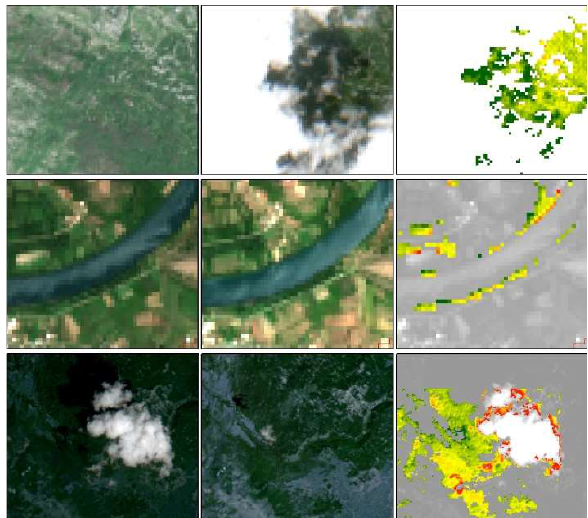
Figure 7. Misclassification due to errors present in the classification process related to cloud shadows (upper row), misregistration (middle row) and clouds (lower